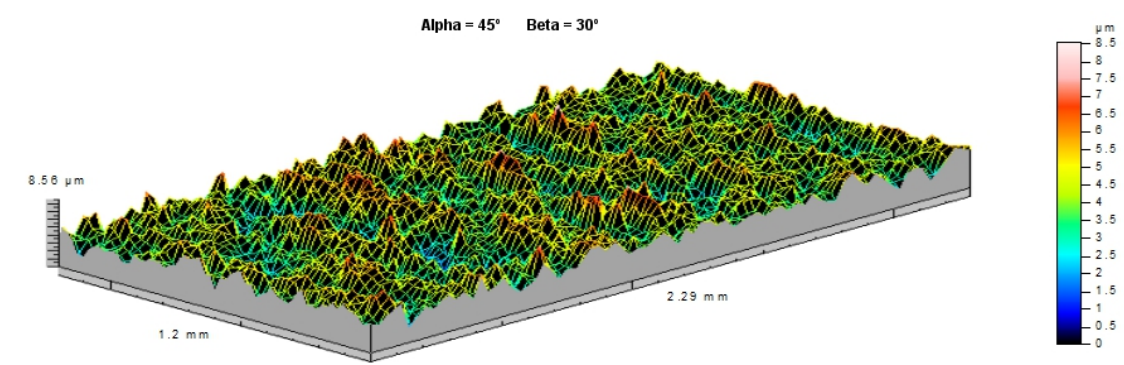
Figure 12. Roughness of the samples Sa = 0.833 µ m, Sq = 1.05 µ m, St = 8.56 µ m, Str = 0.262 µ m, and Sk = 2.1 µ m (Taylor Hobson Ltd., Leicester, U.K.).